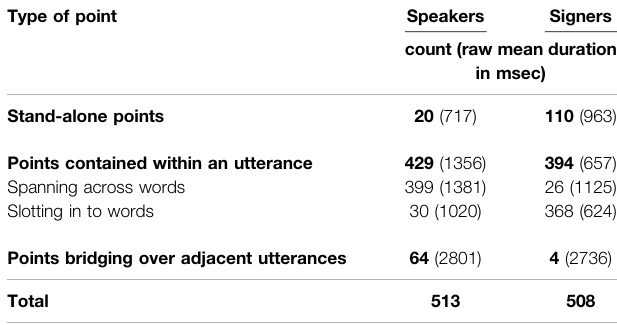
TABLE 2 | Structural